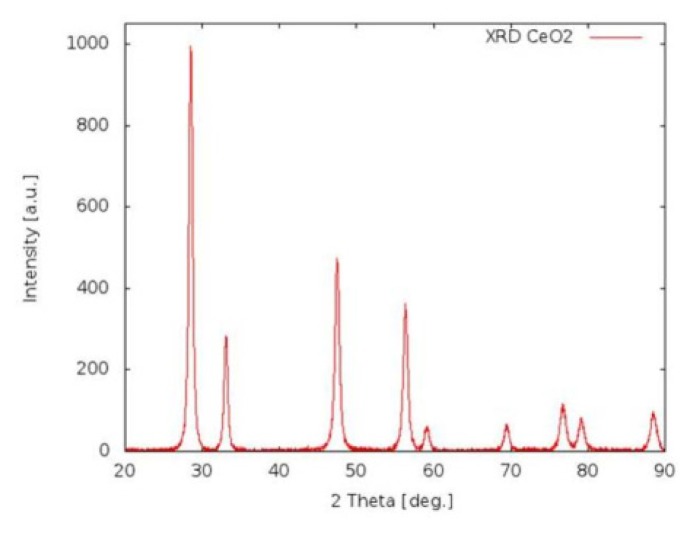
X-Ray diffraction evaluation of CeO2-NP crystalline phase production.